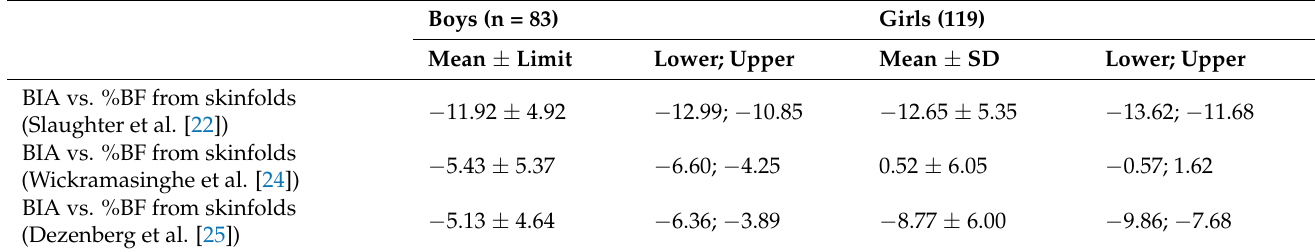
Table 5. Limits of agreement between the percentage body fat (%BF) obtained from bioelectrical impedance analysis (BIA) and various prediction